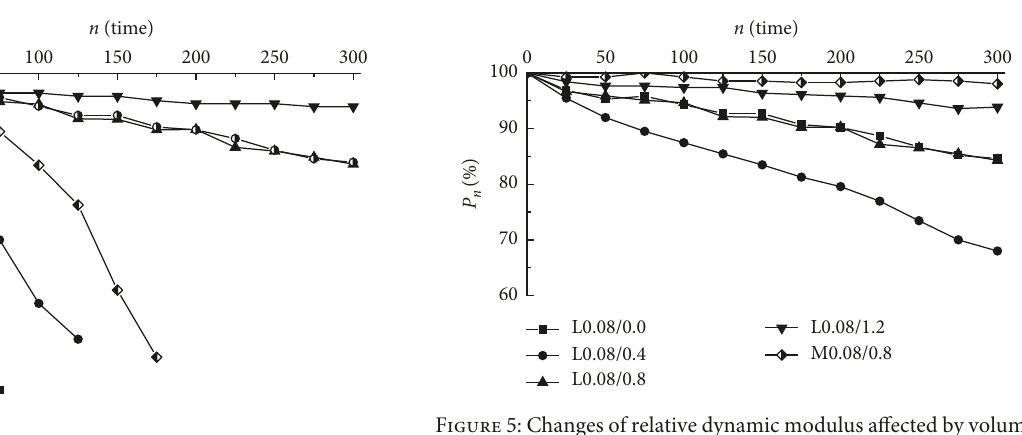
Figure 5: Changes of relative dynamic modulus affected by volume fraction of steel fibers and fine